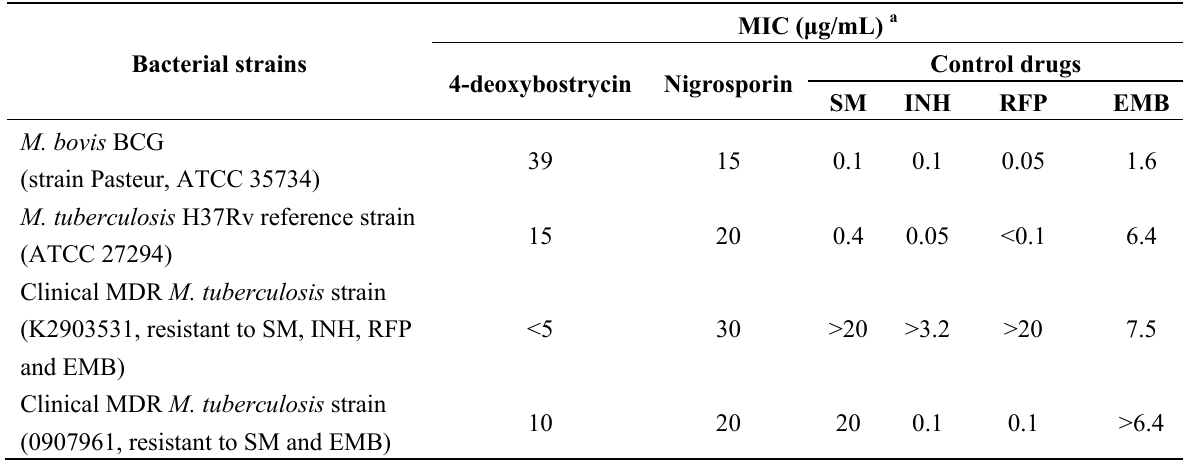
Table 1. MIC of 4-deoxybostrycin and nigrosporin to BCG, M. tuberculosis and other mycobacterial